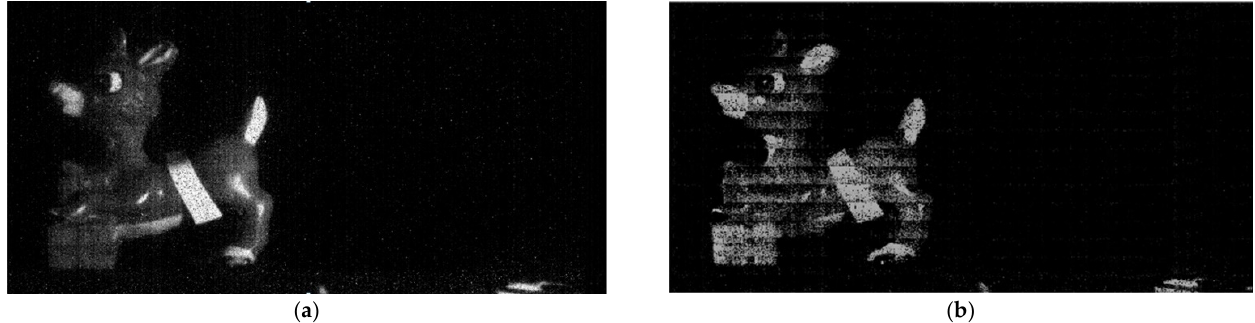
Figure 14. Average bit densities: ( a ) column average and ( b ) row average.